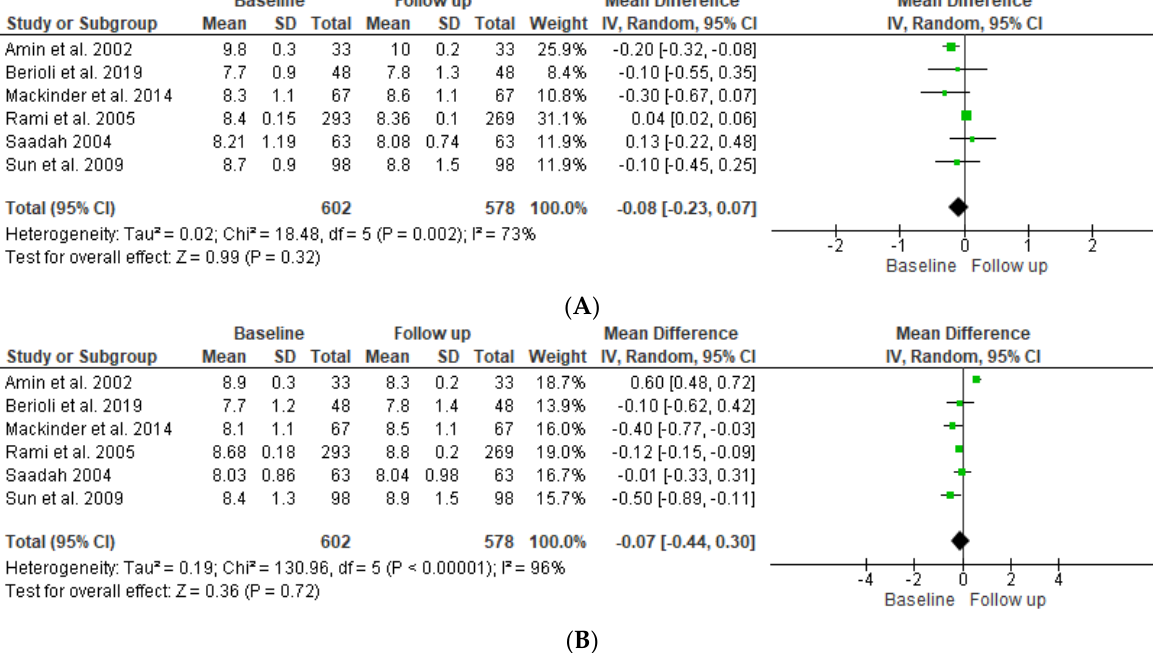
Table 2. Effects of GFD in pediatric patients with a dual diagnosis of T1DM and asymptomatic CD.